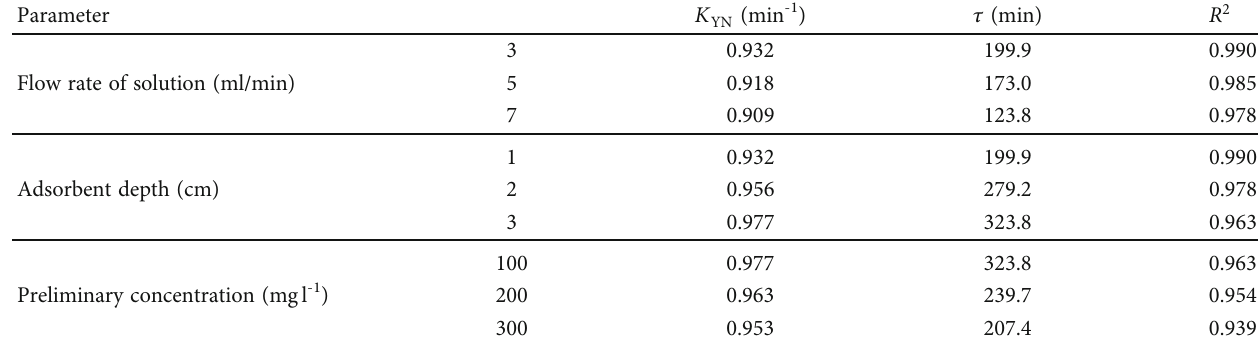
Table 4: Parameters and constants of the Yoon-Nelson model for the removal of CV by MGP.